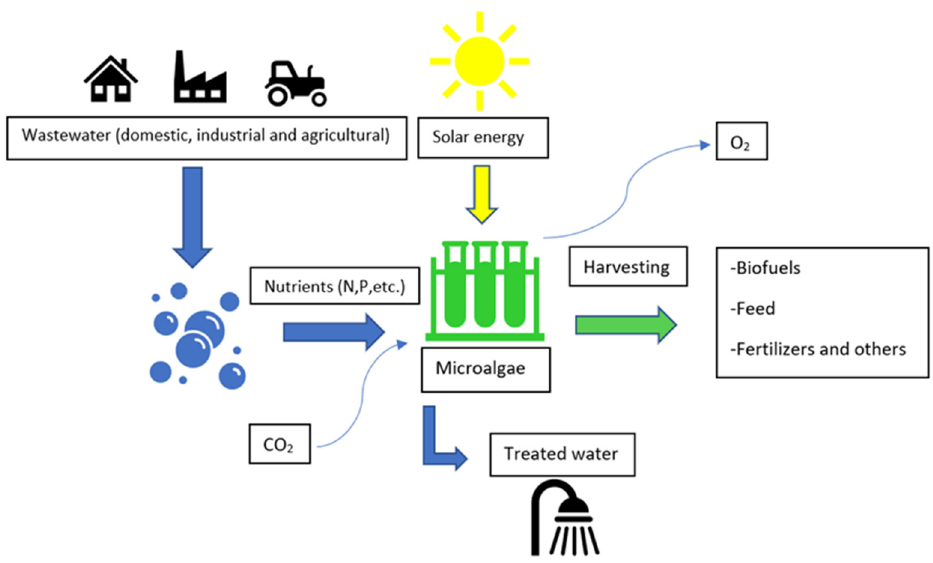
Figure 1. The production of biofuels from microalgae can be combined with the treatment of wastewater from different sources. Thanks to the ability of microalgae to remove pollutants from wastewater, the latter can be reused for different purposes such as agriculture. Likewise, microalgae find nutrients such as phosphorus and nitrogen necessary for their growth and therefore to produce biofuels and other products. Treated water (with low nutrient load) will be thus available for the citizen.